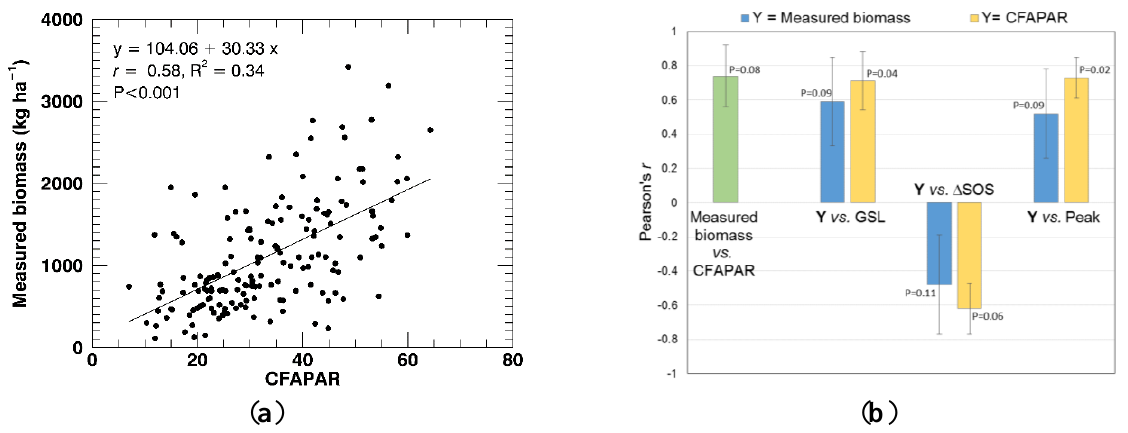
Figure 6. ( a ) Linear regression statistics and scatterplot between measured biomass (years 2005–2011) and CFAPAR; ( b ) average of the site-level correlation coefficients and statistical significance: the green bar refers to the correlation between measured biomass and CFAPAR; the blue and yellow bars refer to the correlations of GSL, ΔSOS and Peak vs. measured biomass (blue) or CFAPAR (yellow), respectively. Error bars refer to ±1 standard